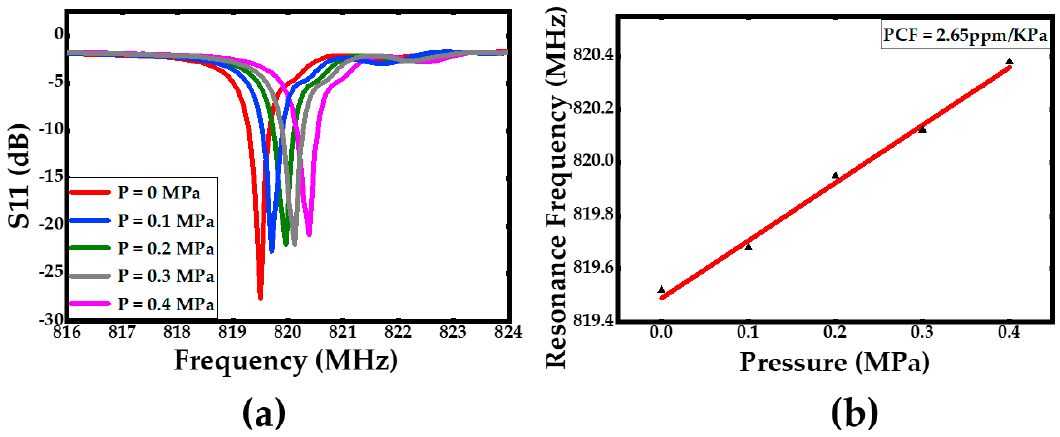
Figure 15. ( a ) The Lamb wave resonator S11 parameters with different pressure in room temperature, ( b ) the pressure dependent resonance frequency with different pressure.